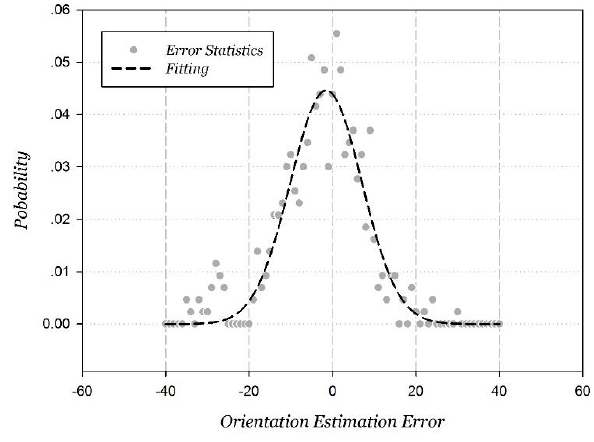
Figure 16. Gaussian fitting orientation measurement error.